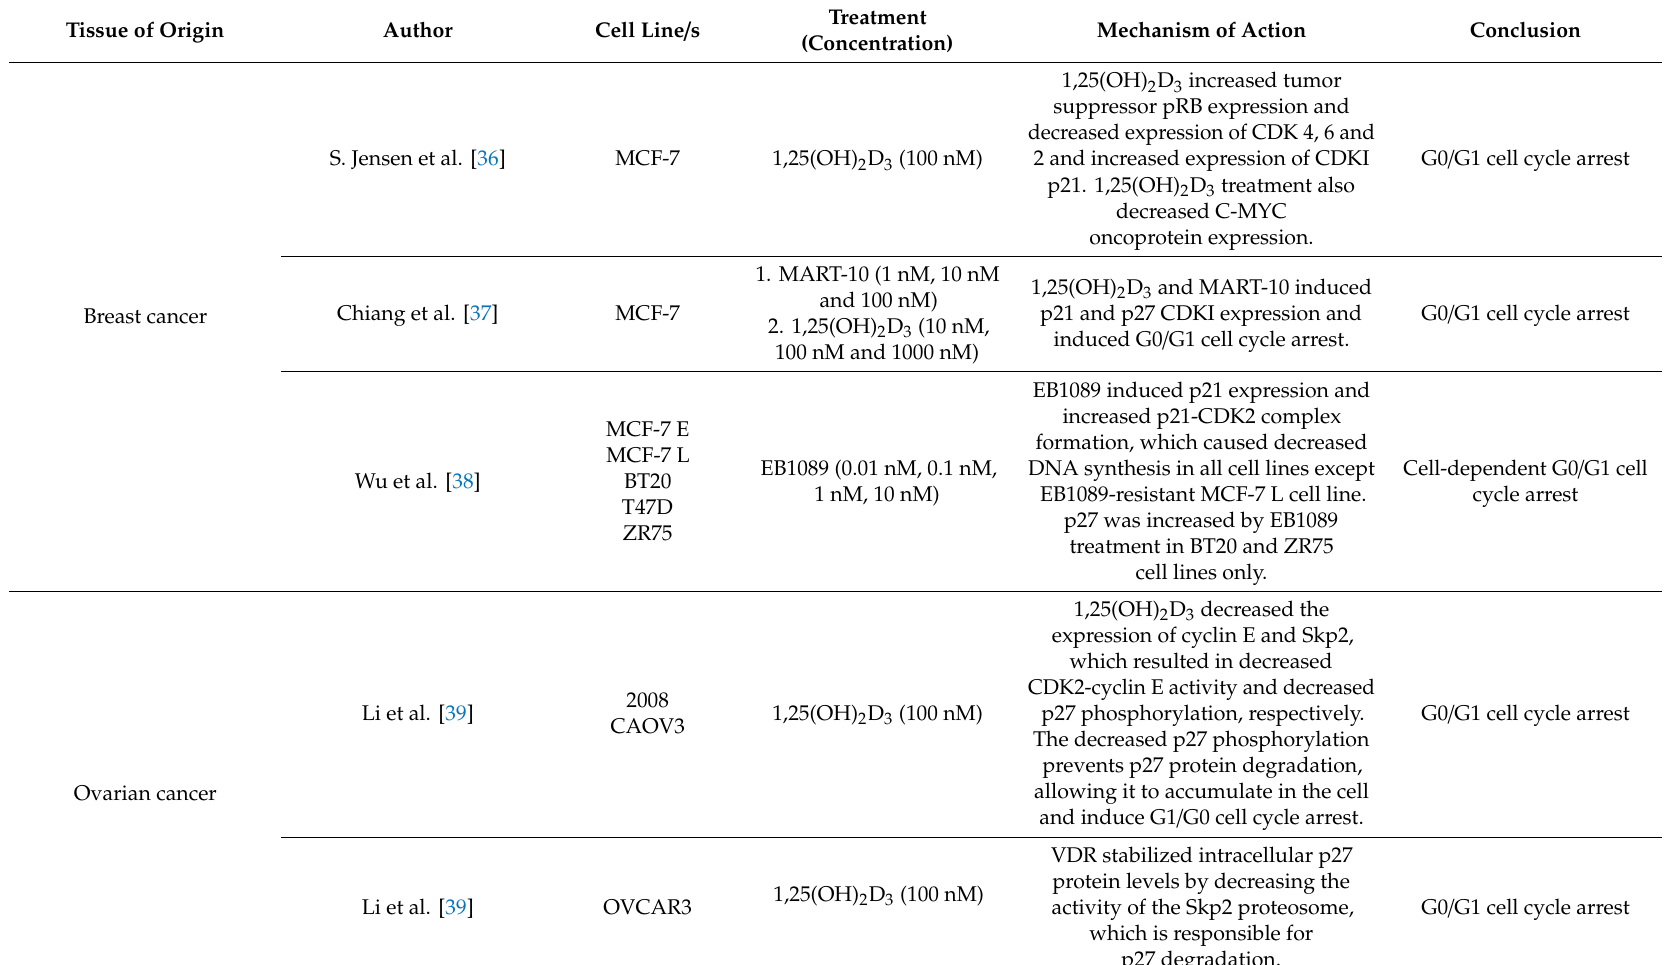
Table 1. Mechanisms of cell cycle arrest induced by calcitriol and / or vitamin D analogues on cancer cell